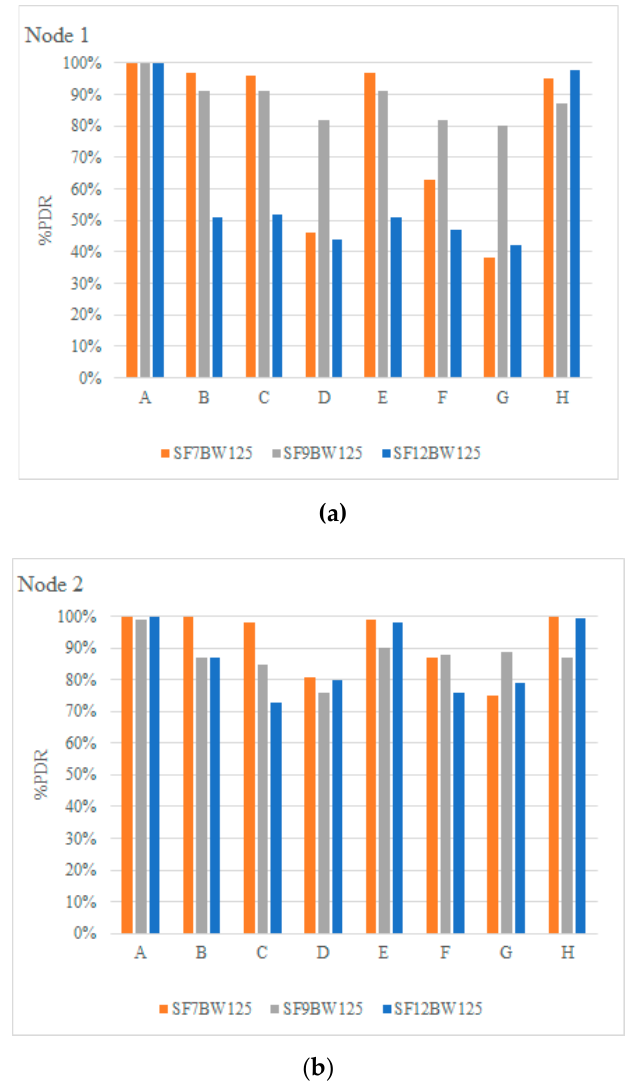
Figure 11. PDR: ( a ) Nodes 1, ( b ) Node 2.